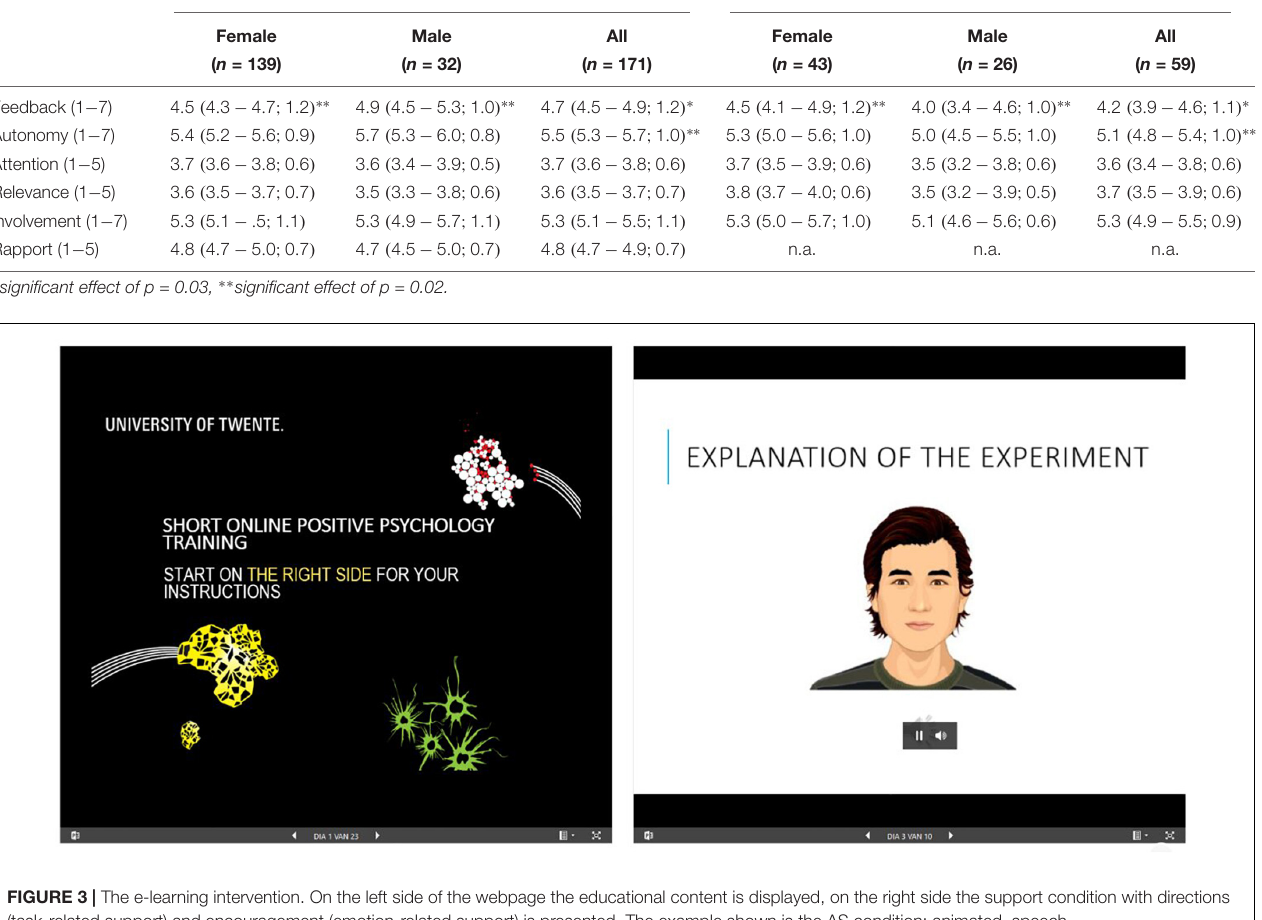
FIGURE 3 | The e-learning intervention. On the left side of the webpage the educational content is displayed, on the right side the support condition with directions (task-related support) and encouragement (emotion-related support) is presented. The example shown is the AS condition; animated,